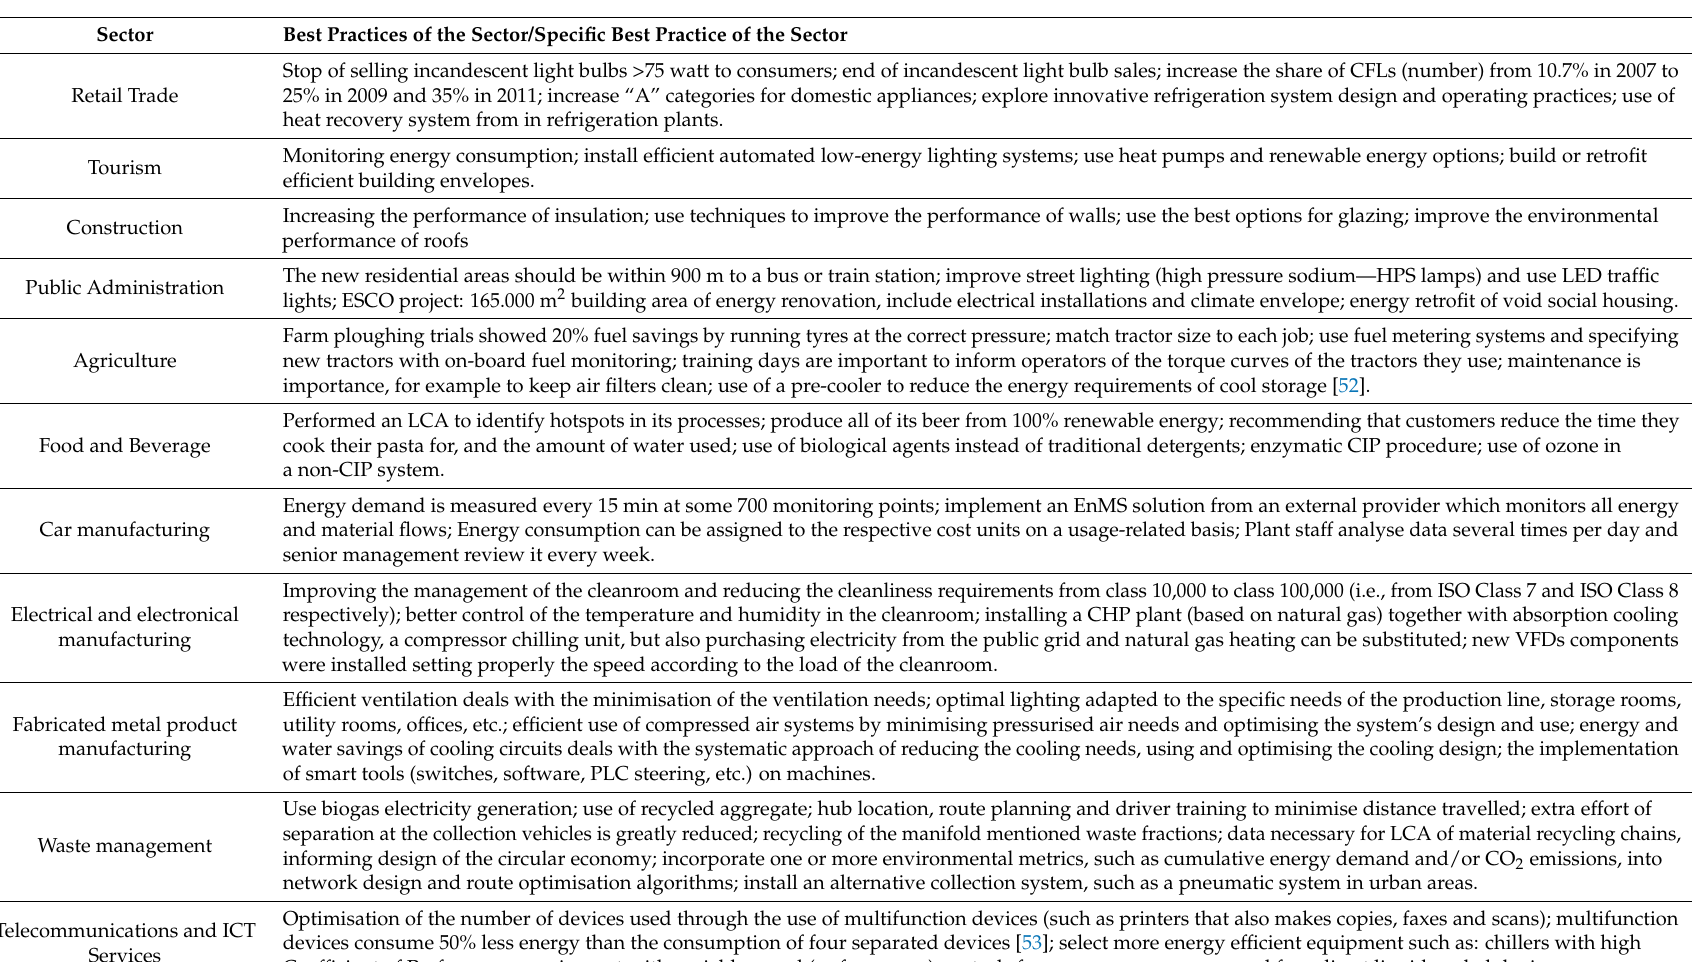
Table 4. Summarized some Best/specific practices of each sector, mentioned in